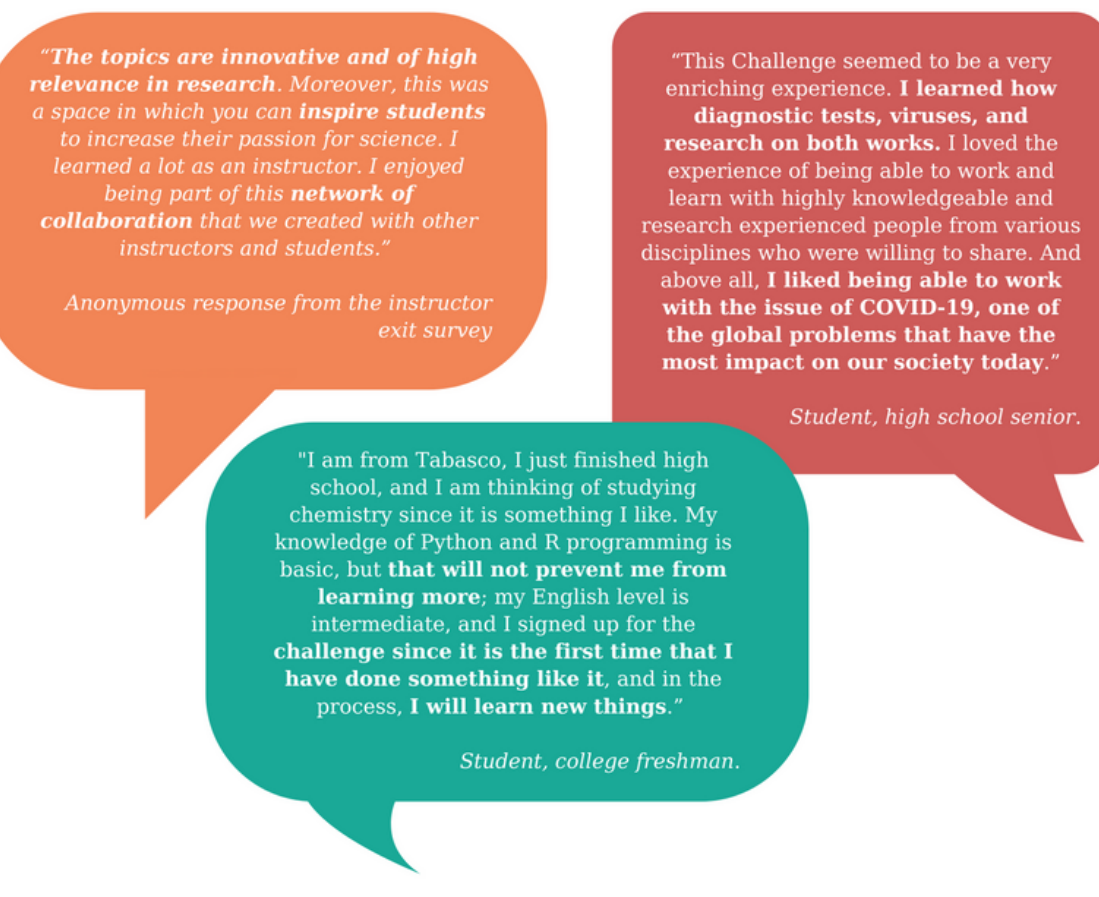
Figure 5. Testimonials from participants. To provide a snapshot of how participants at all levels were feeling during these activities we provide some quotes. These quotes come from the instructors and